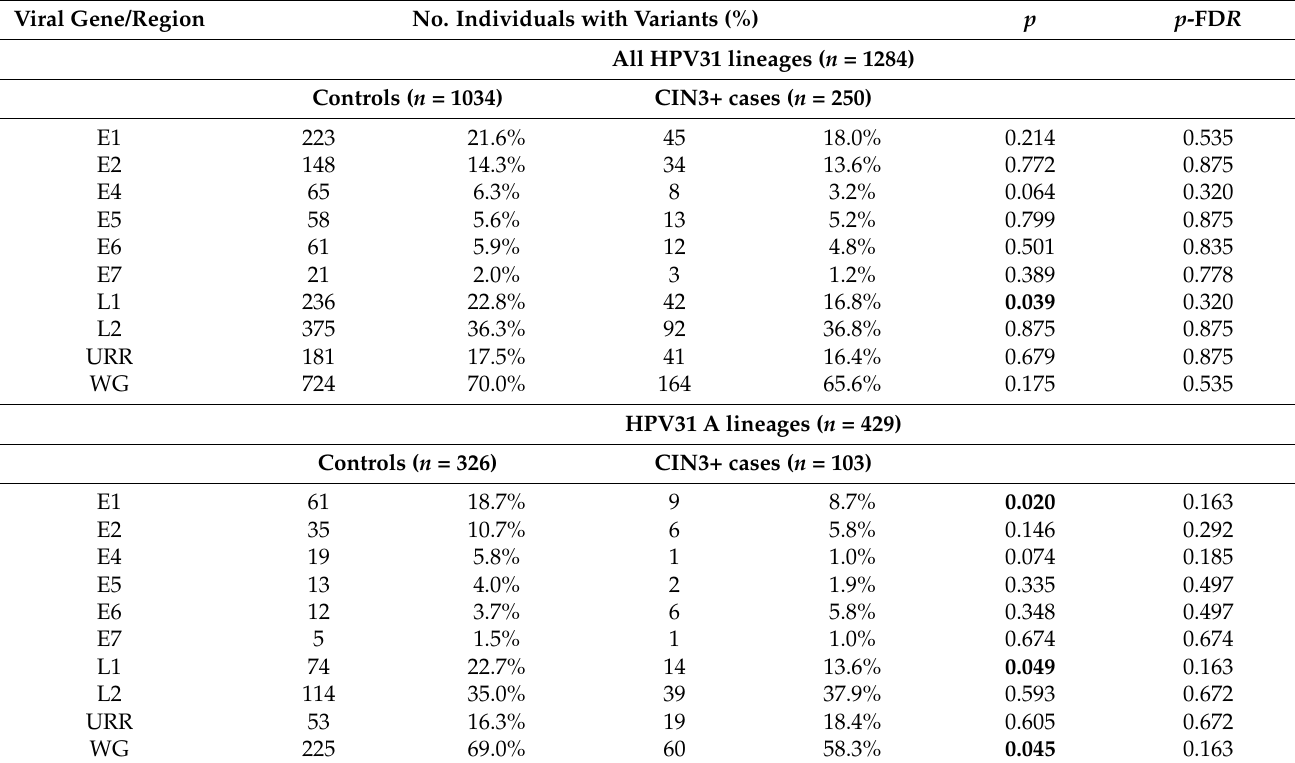
Table 2. Rare variant burden analysis for all HPV31 lineages, and within the A lineage, in the PaP Cohort. Viral Gene/Region No. Individuals with Variants